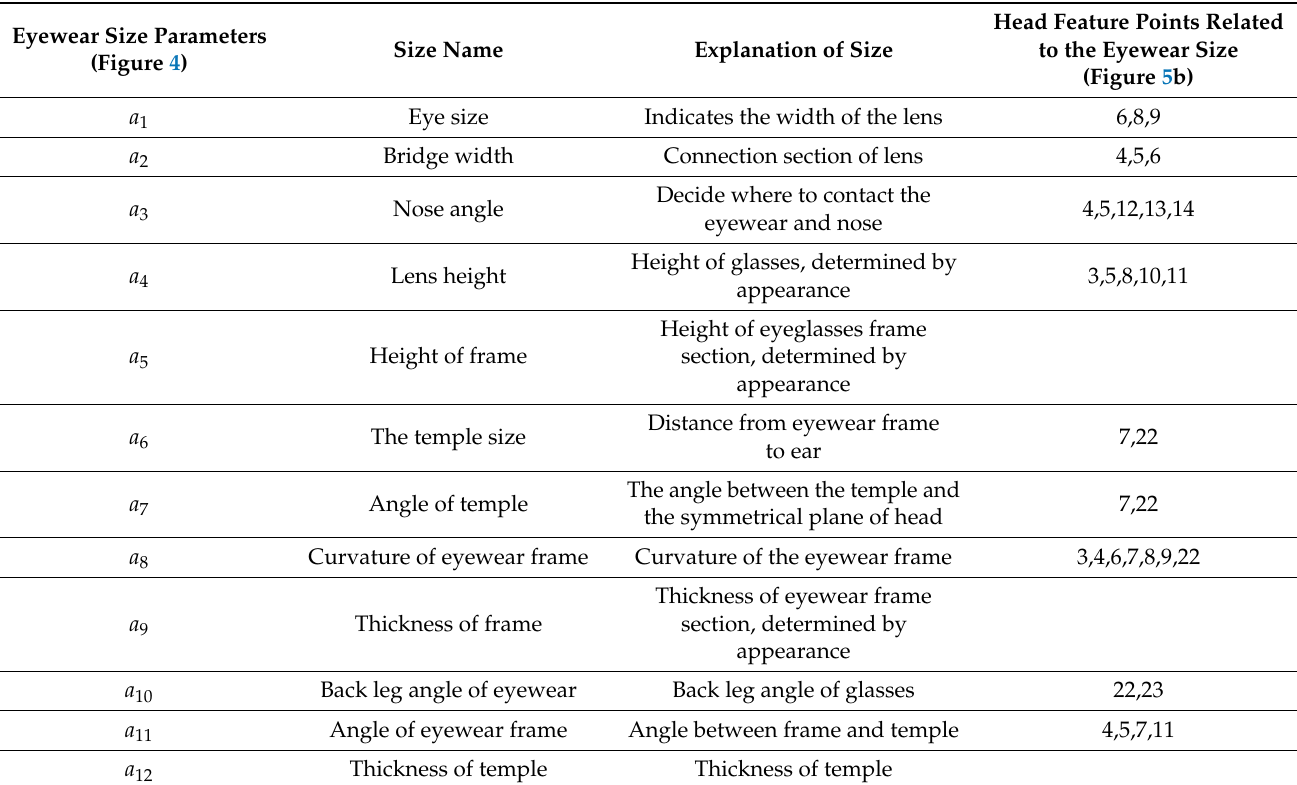
Table 1. Eyewear feature point for